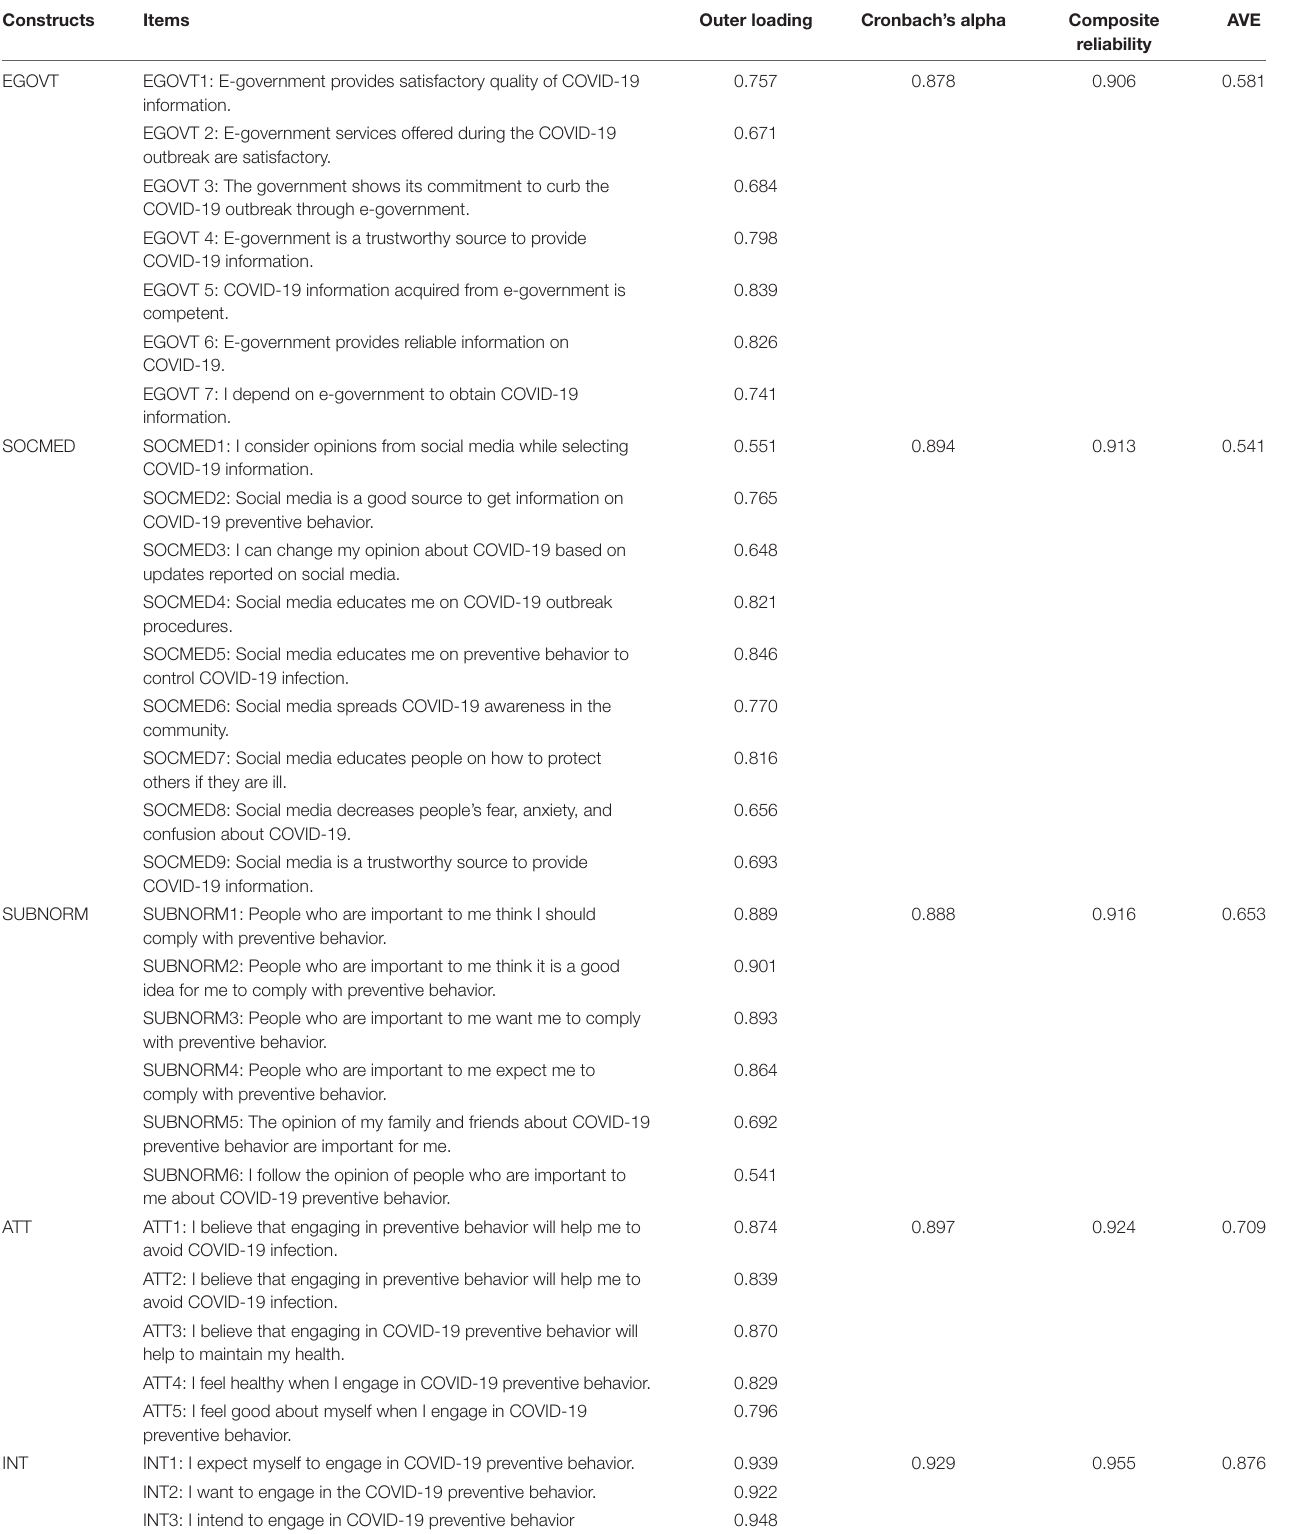
TABLE 2 | Reliability and validity of measurement scales. Constructs Outer loading Cronbach’s alpha Composite